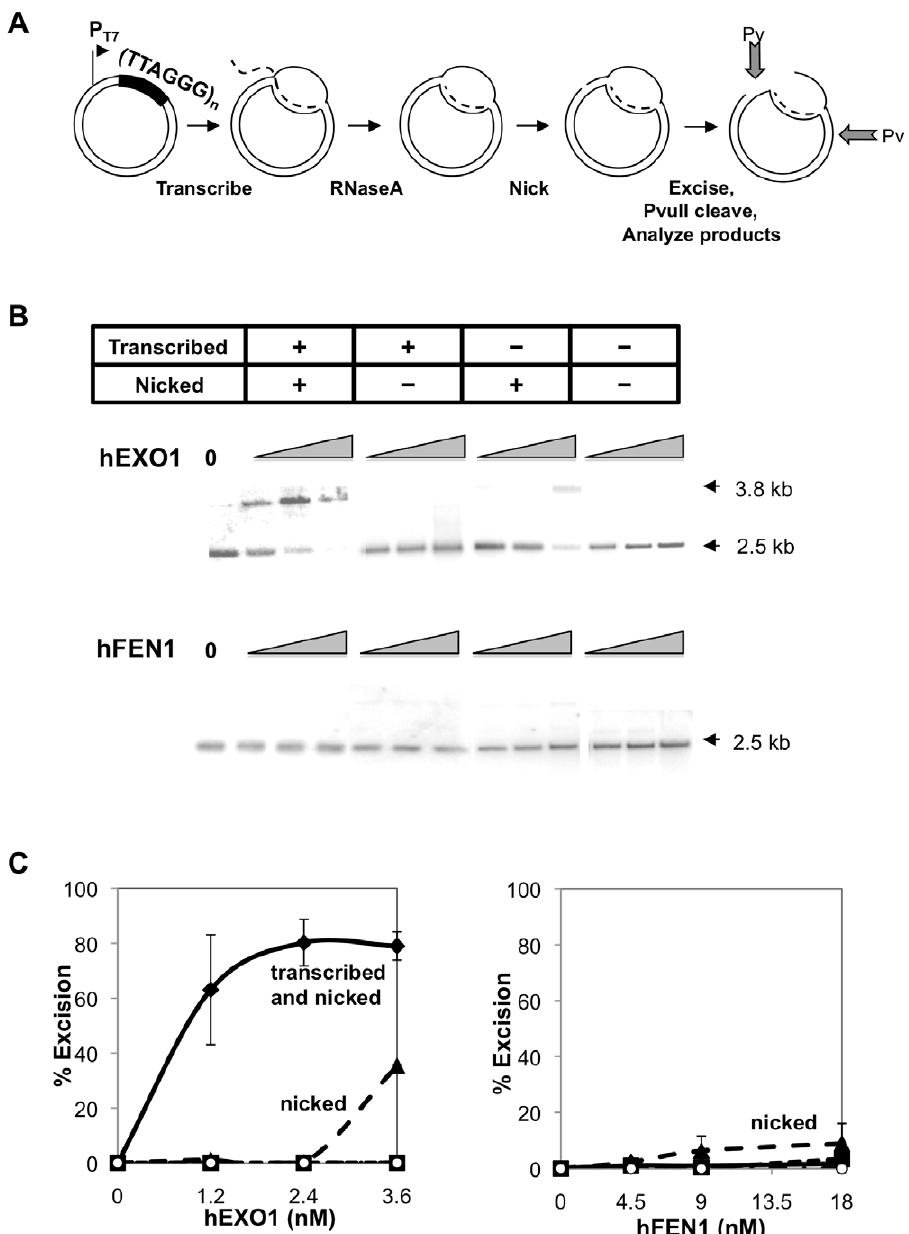
Figure 6. Transcribed telomere repeats are excised by hEXO1 but not hFEN1. (A) pTELN telomeric substrates. T7 promoter (P T7 ); 800 human (TTAGGG) telomeric repeat (dark fill); RNA transcript (dashed line); and PvuII cleavage sites (Pv; arrows) are indicated. (B) Products of PvuII digests of pTELN substrates, which had been transcribed or nicked, as indicated, following digestion with hEXO1 (above, 0.6, 1.2, 2.4 and 4.8 nM) or hFEN1 (below, 0. 4.5, 9 and 18 nM). Fragments were phosphor-imaged and quantitated following transfer and indirect labeling with a probe to the T7 promoter. Arrows denote the 3.8 kb full-length plasmid, and the 2.5 kb PvuII product. (C) Quantitation of products of excision of transcribed, nicked pTELN (diamonds), transcribed, pTELN (squares), nicked pTELN (triangles) and supercoiled pTELN (open circles) by 0, 1.2, 2.4 and 3.6 nM hEXO1 (left) and by 0, 4.5, 9 and 18 nM hFEN1 (right). Open circles and squares are overlapping for hEXO1.